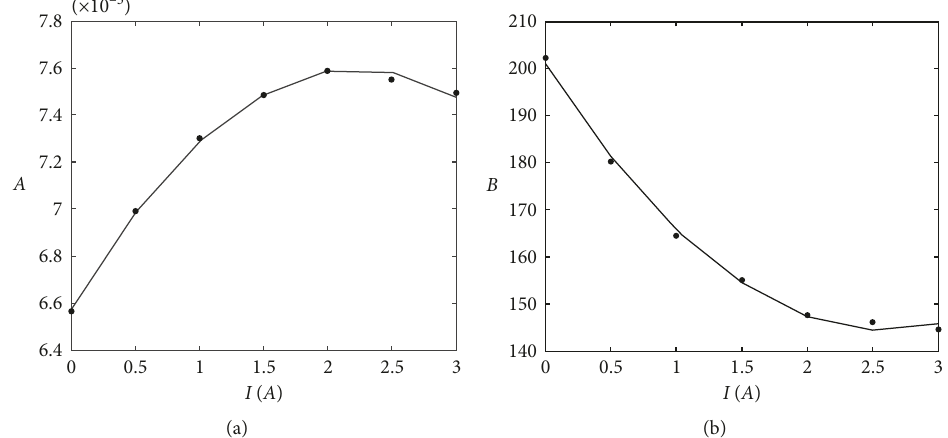
Figure 7: Parameter A , B and current fit graph. The points represent the experimental values, and the line represents the fitted value. (a) Parameter A and current fit graph. (b) Parameter B and current fit graph.